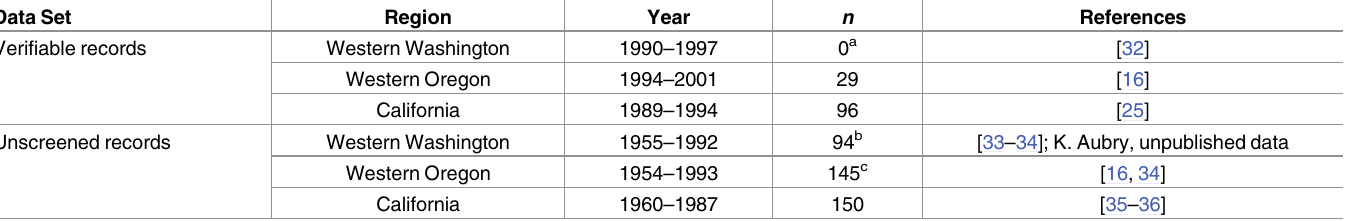
Table 1. Fisher occurrence records from the Pacific States used to evaluate the effectsof data quality on the performance and reliability of Maxent species distribution models. Data